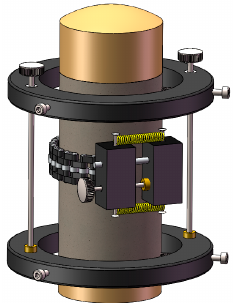
Figure 1. Experimental setup for uniaxial compression.